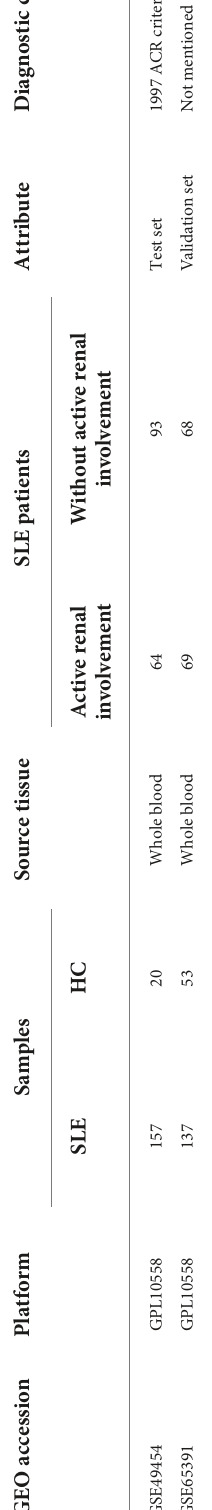
Supplementary Figure 1 . The overall flowchart of this study is shown in Figure 1